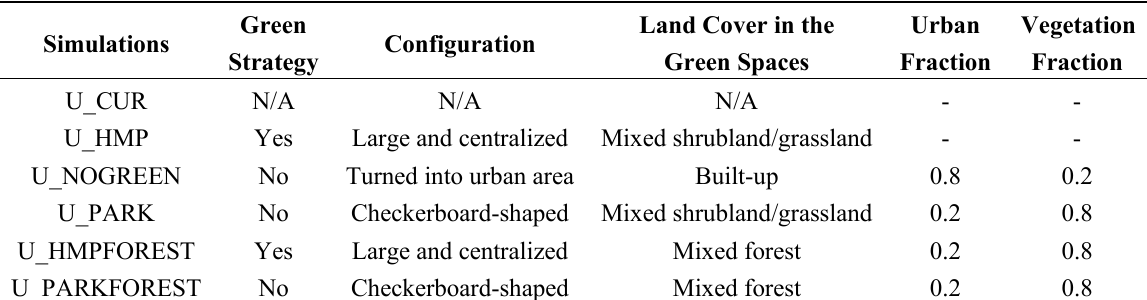
Table 1. Configuration of the green spaces in domain